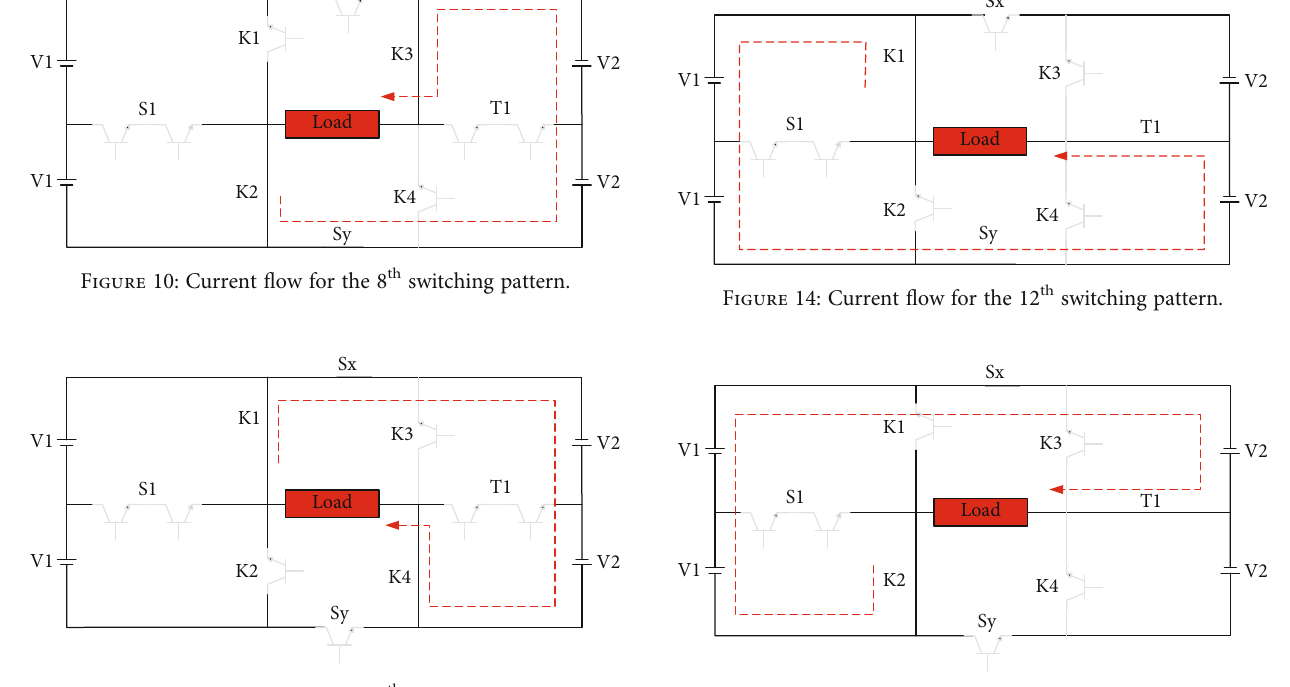
Figure 15: Current fl ow for the 13 th switching